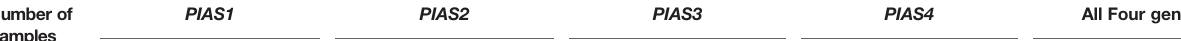
TABLE 4 | Detailed statistics of ROC curve analysis. Number of PIAS1 PIAS2 Samples